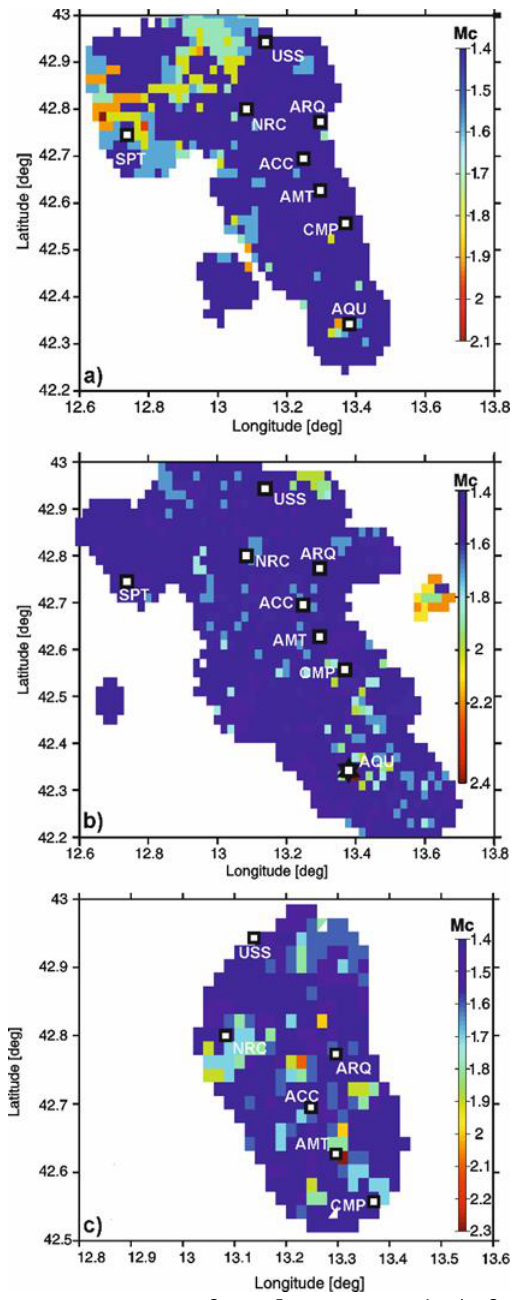
Figure 3. Maps of completeness magnitude for each period (I-II-III in Table1). White squares are the main towns shown in Figure 1 as black